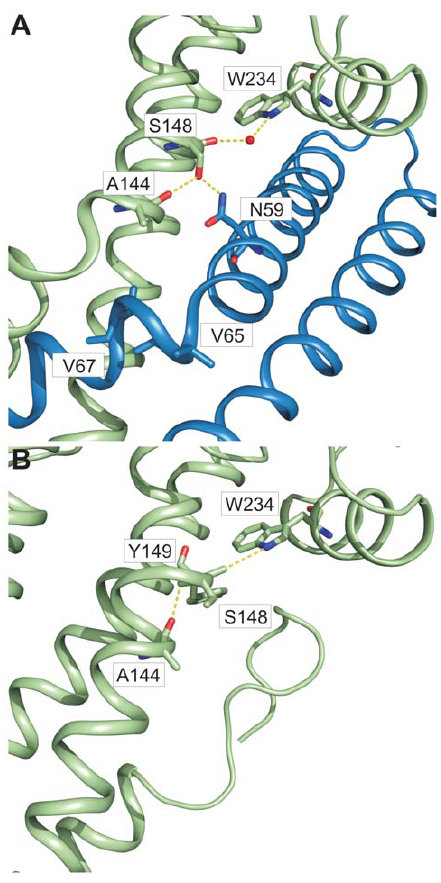
Figure 5. p –bulge in SipD domain 2 permitted the assembly of the PrgI-SipD D D1 complex. Amino acids (stick model) and interac- tions (yellow) that stabilize the p –bulge and helix kinks in the PrgI- SipD D D1 fusion protein (A) and SipD (B) are highlighted.